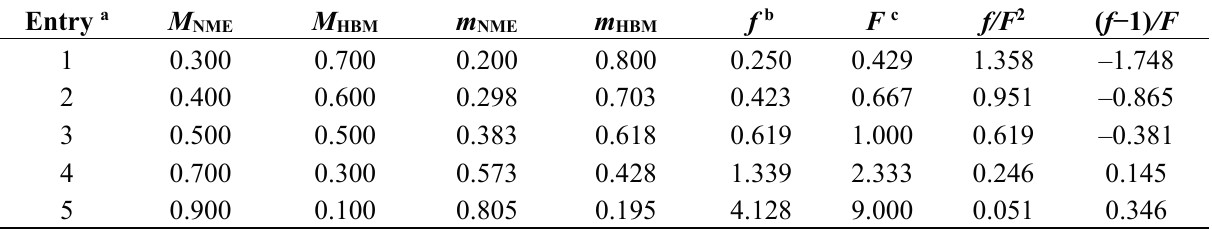
Table A2. Various parameters for calculating reactivity ratios of HBM and 5-Norbornene-2- yl Methyl 2-Ethylhexanoate (NME).